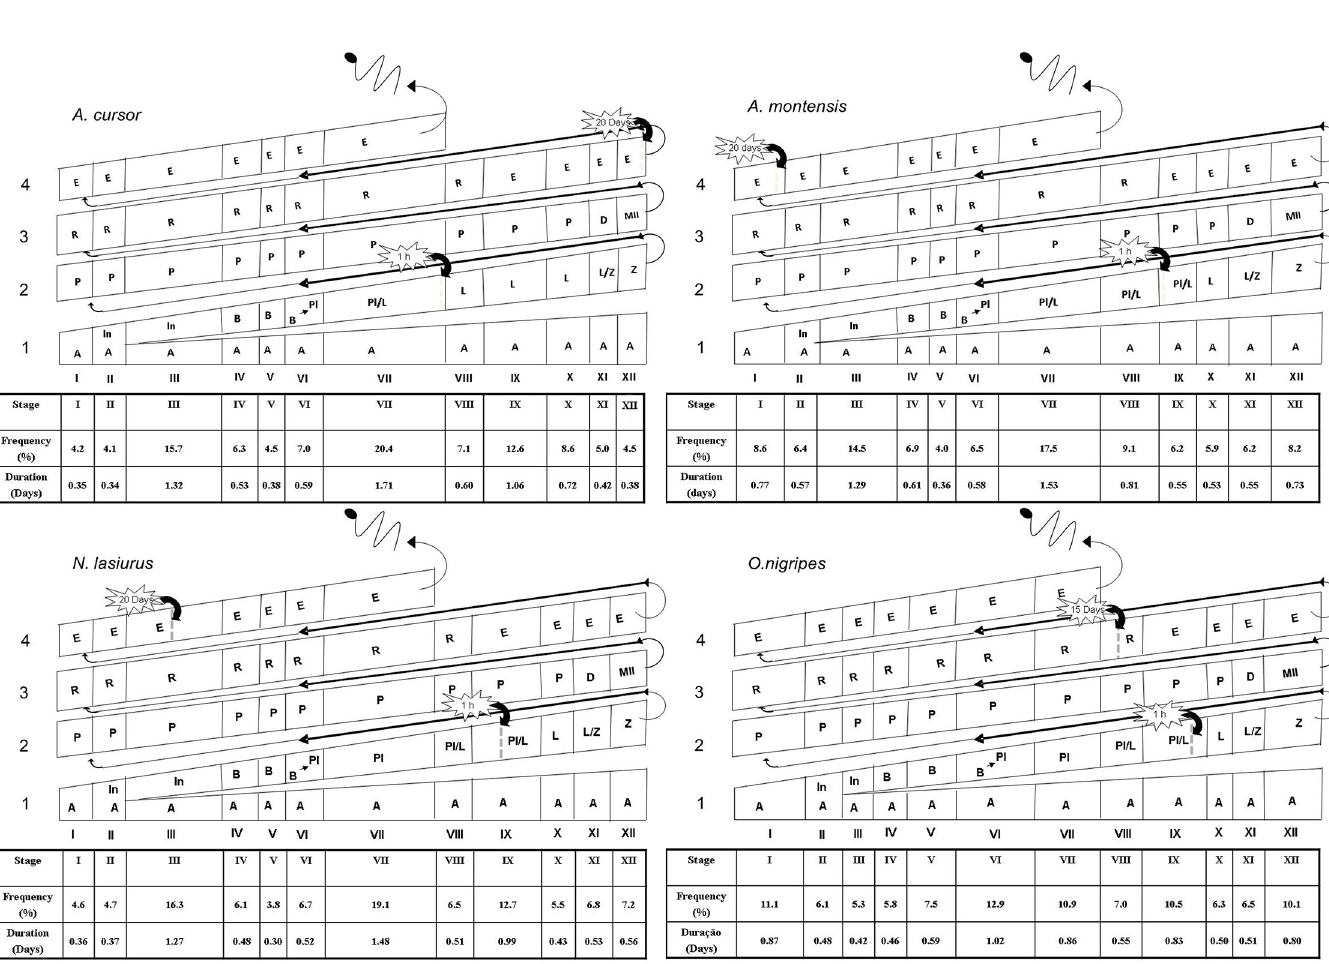
Fig 3. Schematic illustration of the frequencies (%) and duration (days) of the twelve stages of the seminiferous epithelium cycle characterized according to the development of the acrosome in the spermatids in A . cursor , A . montensis , N . lasiurus and O . nigripes . The most advanced germ cell labeled, one hour and 15 or 20 days after thymidine injection, is indicated by the thick arrow. The space corresponding to each stage of the cycle is proportional to its frequency and duration. Abbreviations: type A spermatogonia (A); intermediate spermatogonia (In); type B spermatogonia (B); pre-leptotene spermatocytes (Pl); pre-leptotene in the transition to leptotene spermatocytes (Pl/L); leptotene spermatocytes (L); leptotene in transition to zygotene spermatocytes (L/Z); zygotene spermatocytes (Z); pachytene spermatocytes (P); diplotene spermatocytes (D); secondary spermatocytes and meiotic divisions (MII); round spermatids (R); and elongating/elongated spermatids (E).